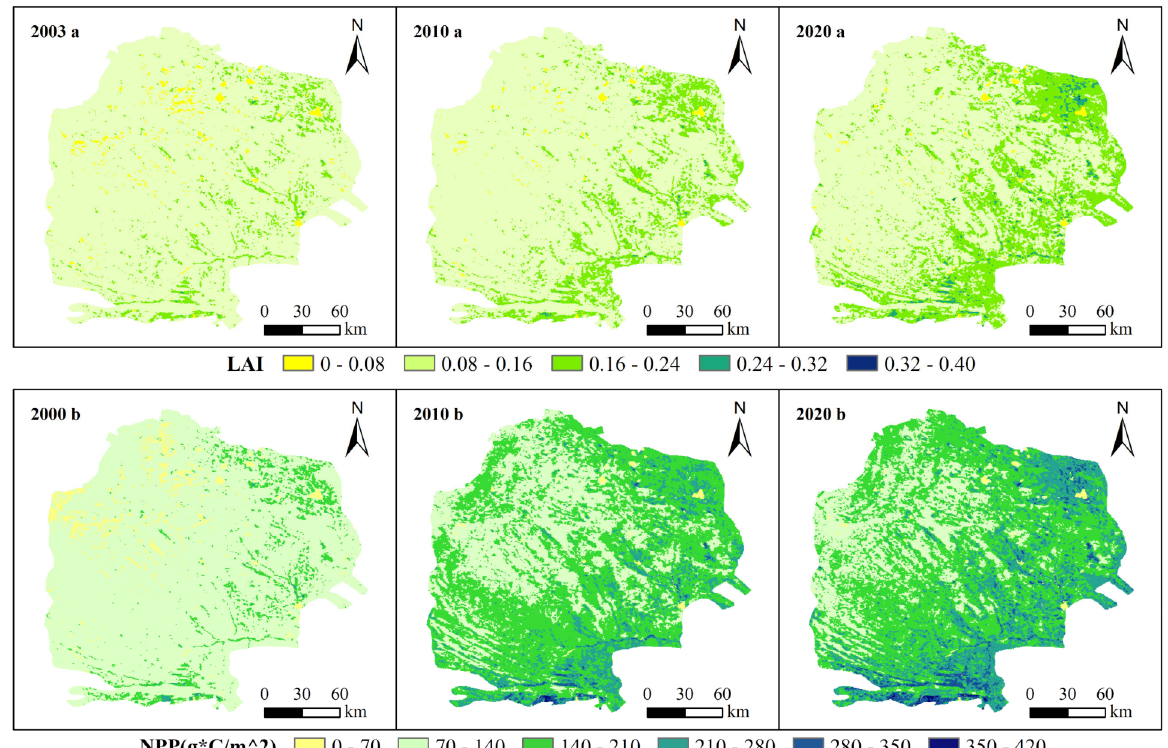
Figure 5. Spatial distribution trends of the LAI and NPP in the Mu Us Sandy Land (a denotes LAI and b denotes NPP).